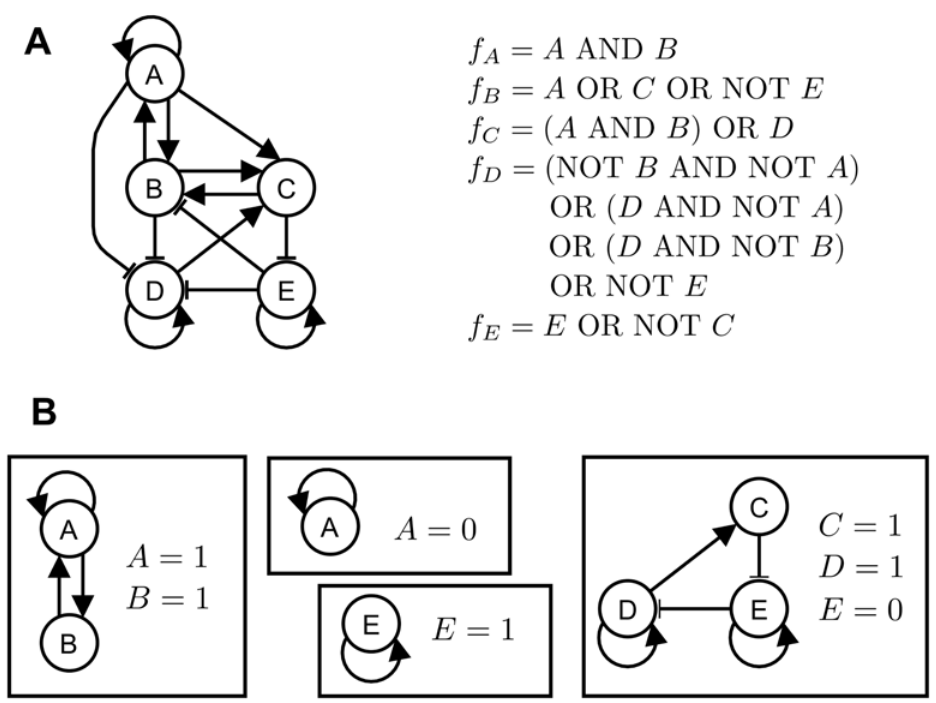
Fig 1. Stable motifs of a logical (Boolean) network. (a) An example of a logical network indicating the regulatory relationships and the logical update function of each node. (b) The four stable motifs of the logical network in (a) and their corresponding node states. These stable motifs are strongly connected components and partial fixed points of the logical network.